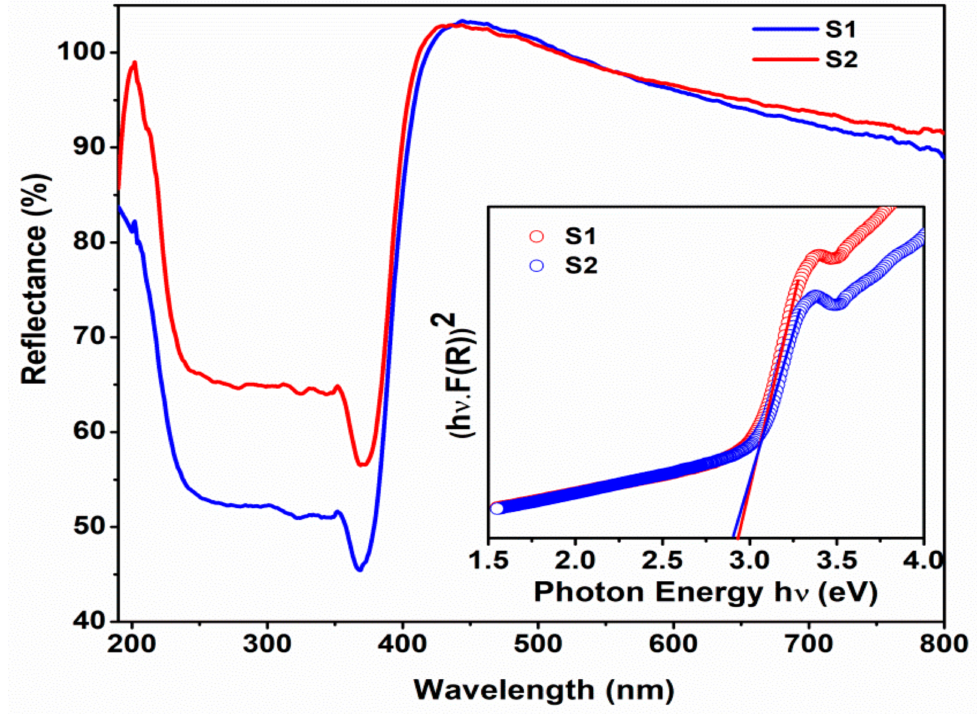
Figure 5. UV-Vis diffused reflectance spectra of ZnO/graphene nanocomposites. (Insert -Tauc